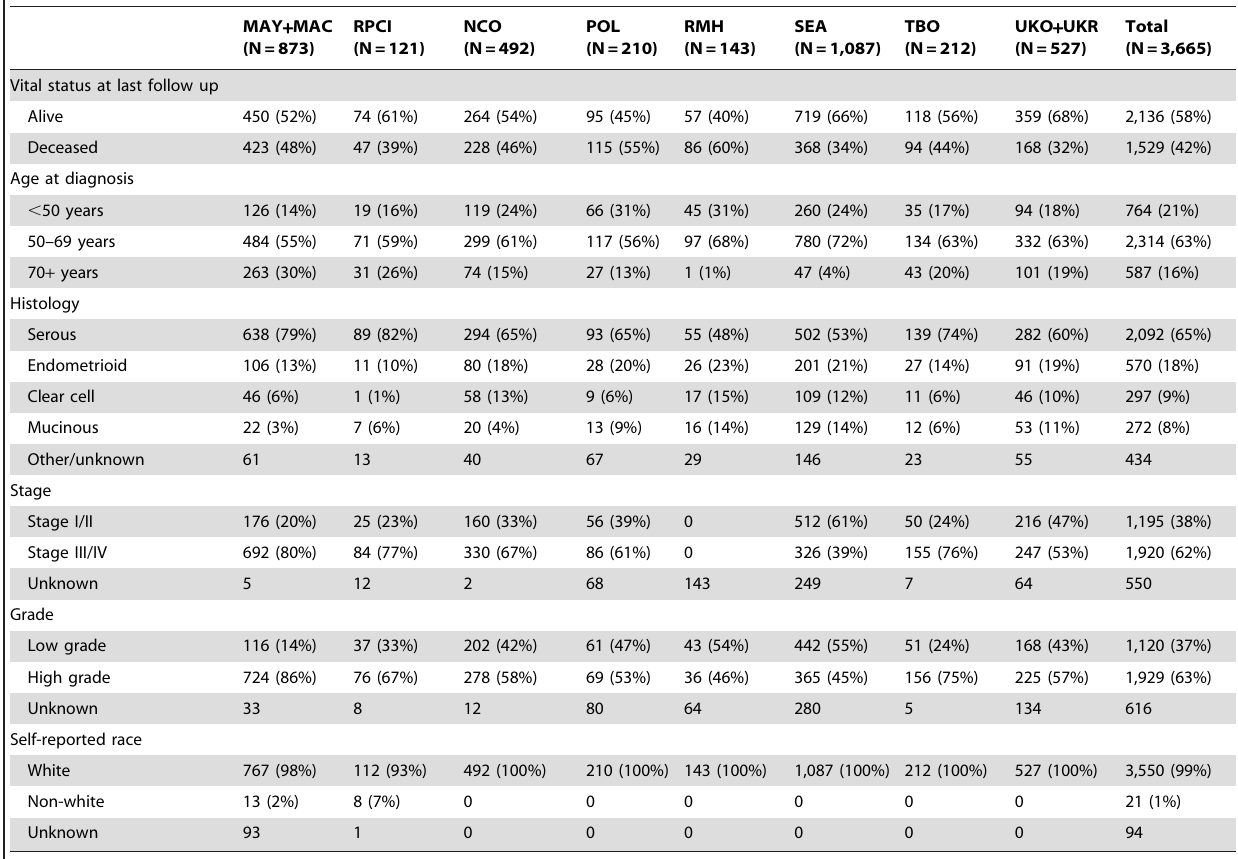
Table 1. Distributions of Ovarian Cancer Clinical Characteristics by Study.